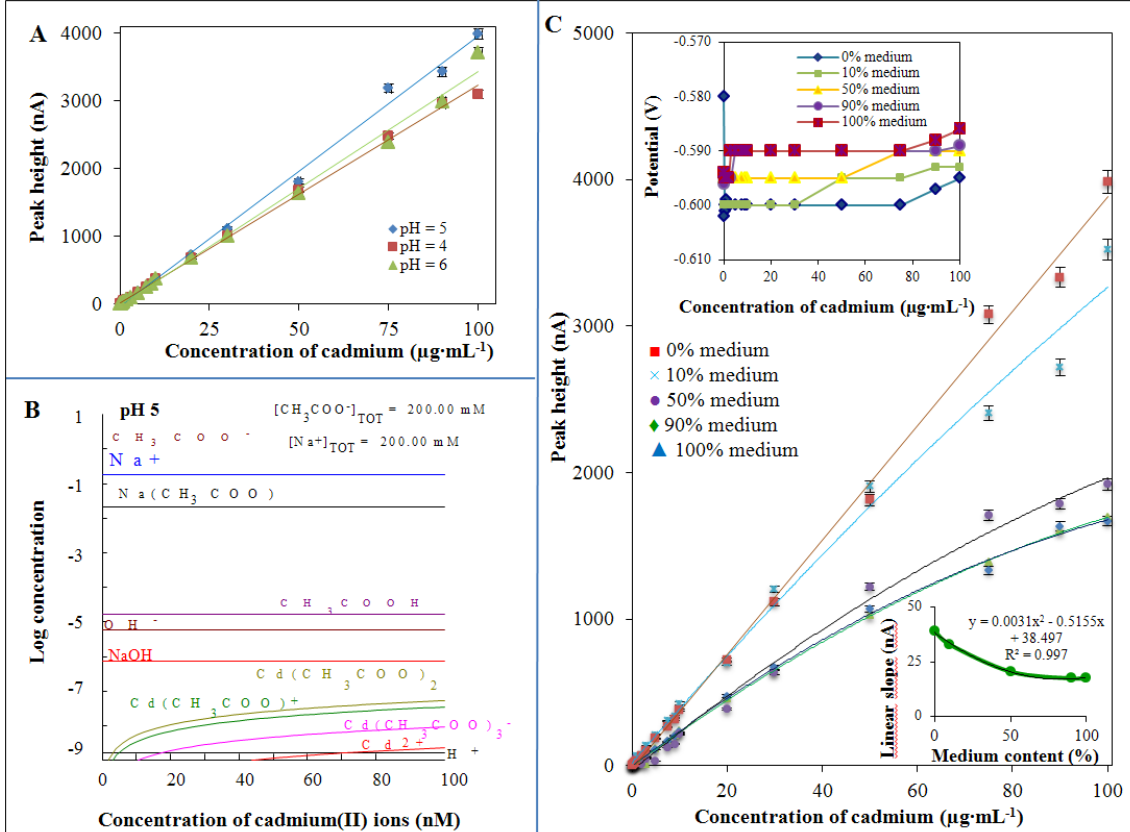
Figure 2. ( A ) Dependencies of peak height of cadmium(II) ions on their concentrations measured in the presence of acetate buffer pH 4, 5 and 6; ( B ) Mathematical modelling of cadmium(II) ions behaviour in the presence of 0.2 M acetate buffer, pH 5; ( C ) Changes in the peak height of cadmium(II) ions measured in the presence of 0, 10, 50, 90 and 100% ( v / v ) of cultivation medium in supporting electrolyte. Changes in (upper inset) potentials of the peaks and (upper inset) linear slopes with the increasing content of cultivation medium in supporting electrolyte as 0.2 M acetate buffer, pH 5. Differential pulse voltammetric measurements were carried out under the following parameters: deoxygenating with argon 90 s; deposition potential −0.8 V; time of deposition 240 s; start potential −0.8 V; end potential 0.15 V; pulse amplitude 0.025 V; pulse time 0.04 s; step potential 5.035 mV; time of step potential 0.4 s.